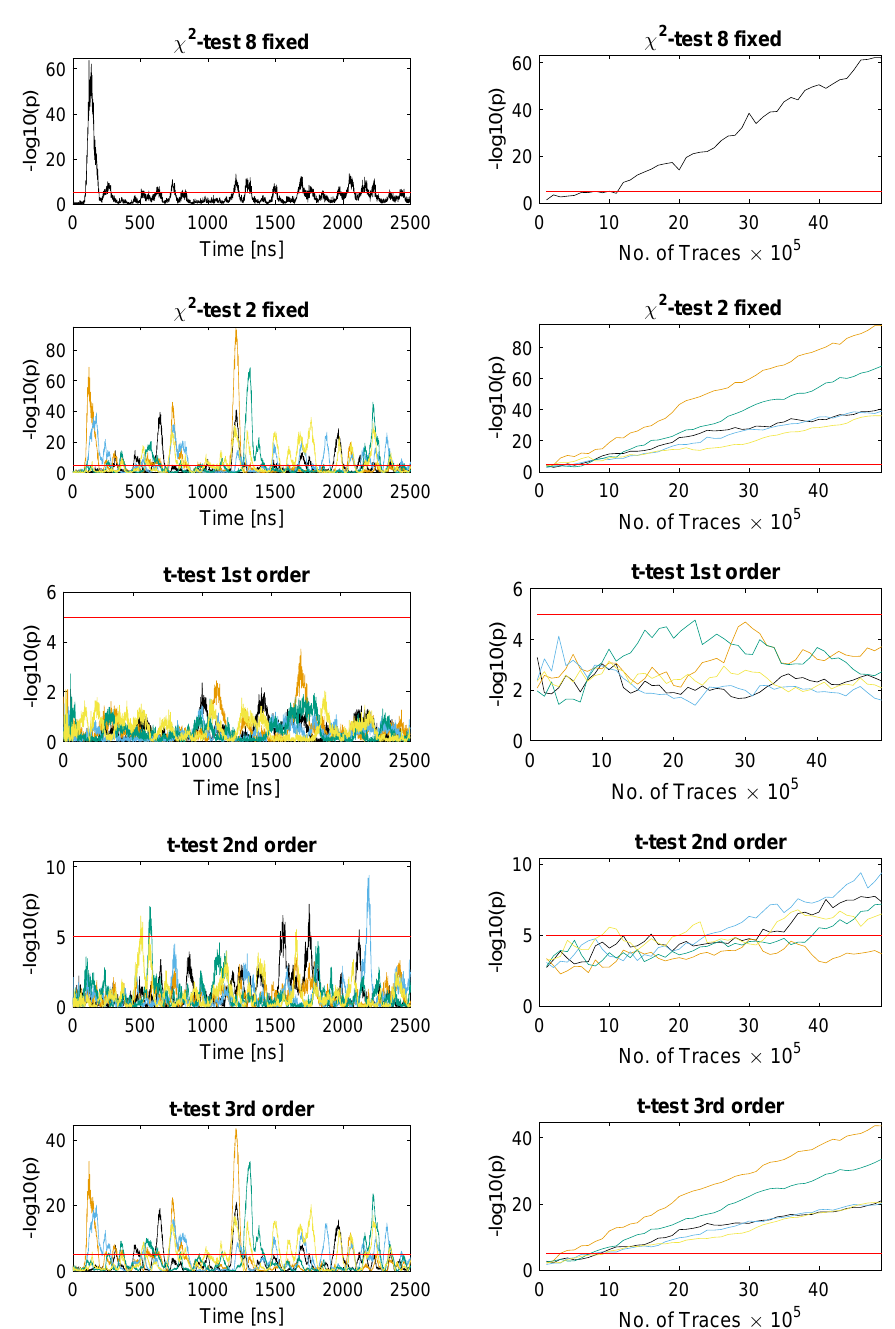
Figure 8: Results of the fixed-vs-fixed test using χ 2 , and 1st- to 3rd-order t -test. The colors represent different combinations of two fixed